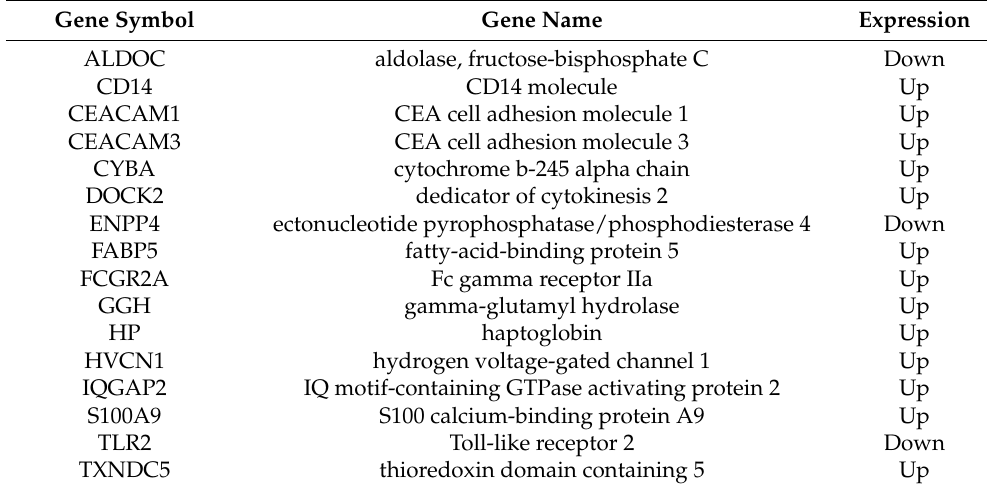
Table 2. Genes participating in the neutrophil-mediated immunity process and their corresponding differential expression status in COVID-19. Up represents upregulated; down represents downregulated. Gene Symbol Gene Name Expression